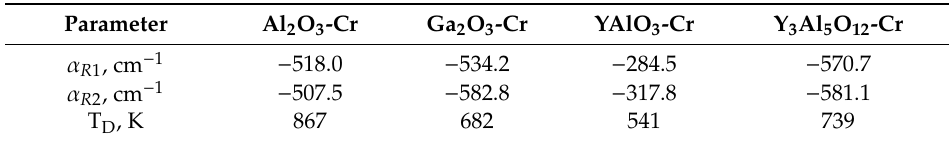
Figure 6. Positions of the R 1 - (red) and R 2 - (black) lines in Al 2 O 3 -Cr ( a ), Ga 2 O 3 -Cr ( b ), YAlO 3 -Cr ( c ), and Y 3 Al 5 O 12 -Cr ( d ) as a function of temperature. The dots are experimental data points and the curves show the best fit of experimental results for Equation (2), using parameters presented in Table 2. Table 3. Parameters of fits obtained from the temperature dependence of the luminescence wavelength shift in Equation (3) for Cr-doped oxides investigated in this work.